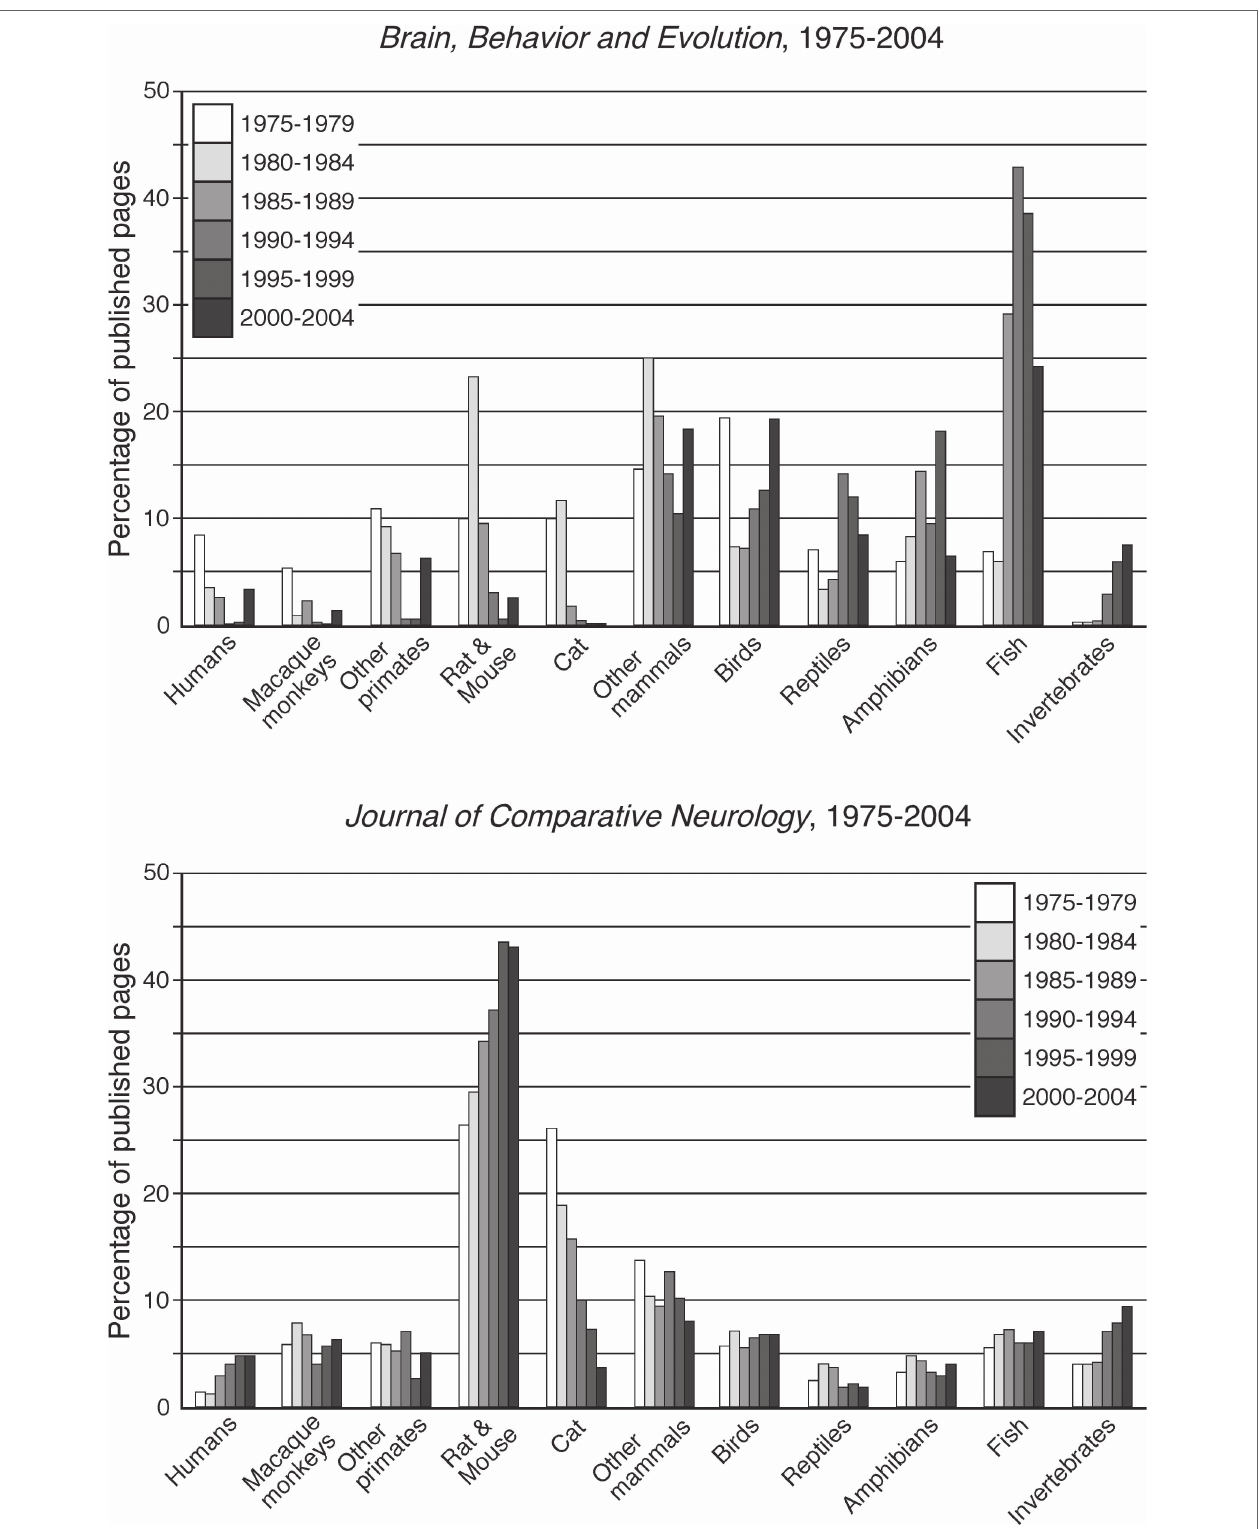
FIGURE 2 | Bar graphs representing the percentage of published pages devoted to each of the phylogenetic groupings classifi ed in the present study in 5-year blocks for the period 1975–2004 in each of the two comparative journals. Specifi c trends in the animal species studied can be seen in these